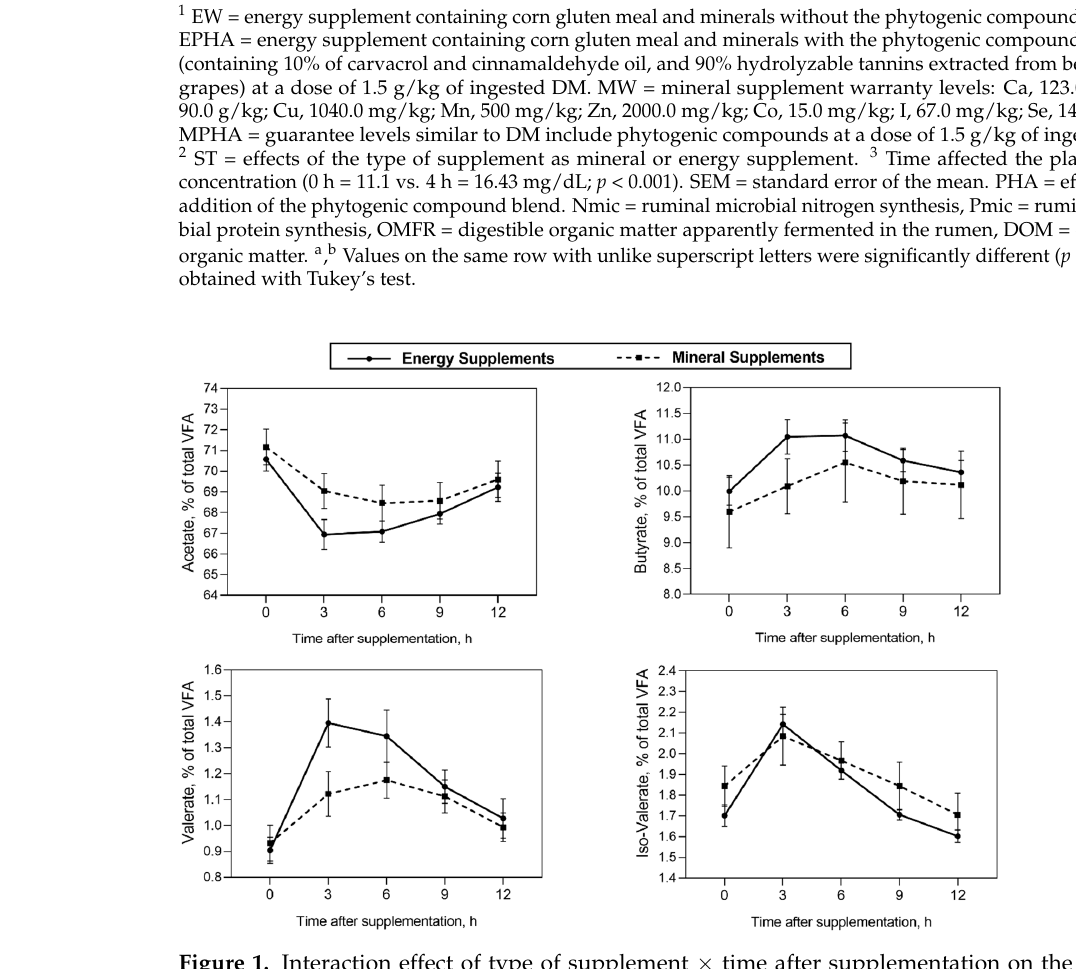
Figure 1. Interaction effect of type of supplement × time after supplementation on the ruminal proportion of acetate ( p < 0.001), butyrate ( p < 0.001), valerate ( p < 0.001), and isovalerate ( p = 0.008) in Nellore cattle grazing Urochloa brizantha cv. Marandu supplemented with energy supplements or mineral